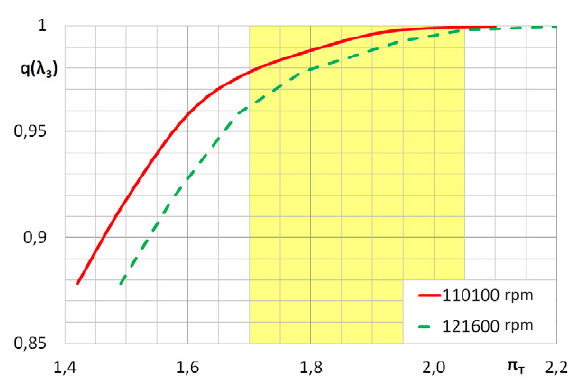
Figure 5. Turbine map (source: Garrett turbocharger turbine maps, n.d.) with operating range highlighted